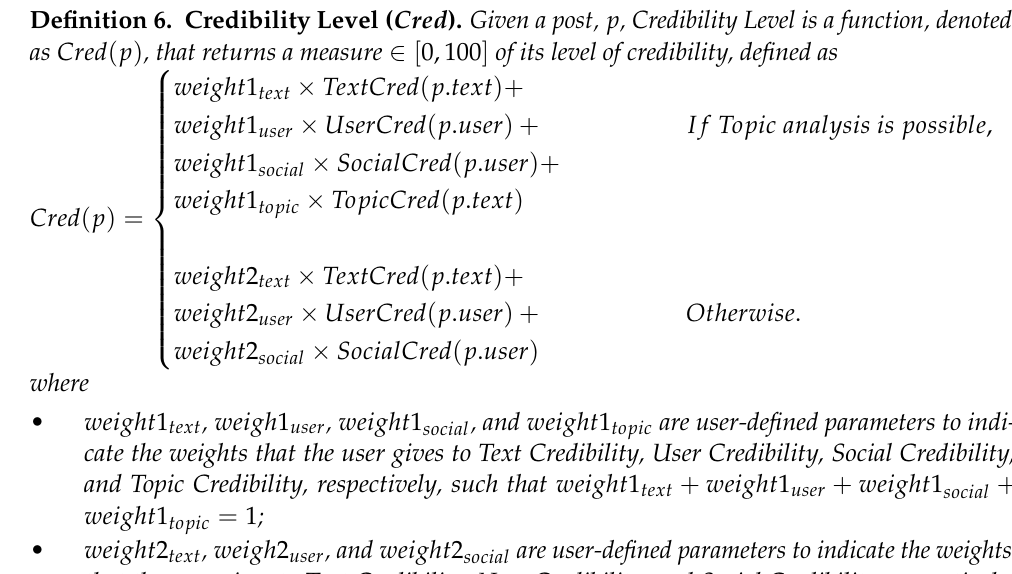
Figure 8. Extended Credibility